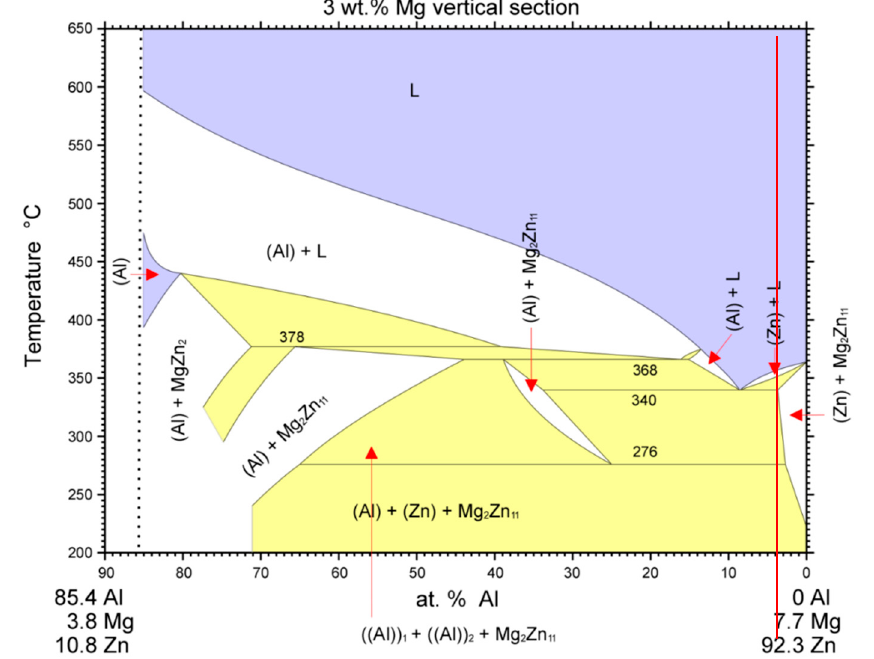
Figure 7. Isopletic cross-section through the ternary system of Al–Mg–Zn for 3 wt % Mg [22]. The red line shows the concentration of Zn5Al3Mg line shows the concentration of Zn5Al3Mg solder.